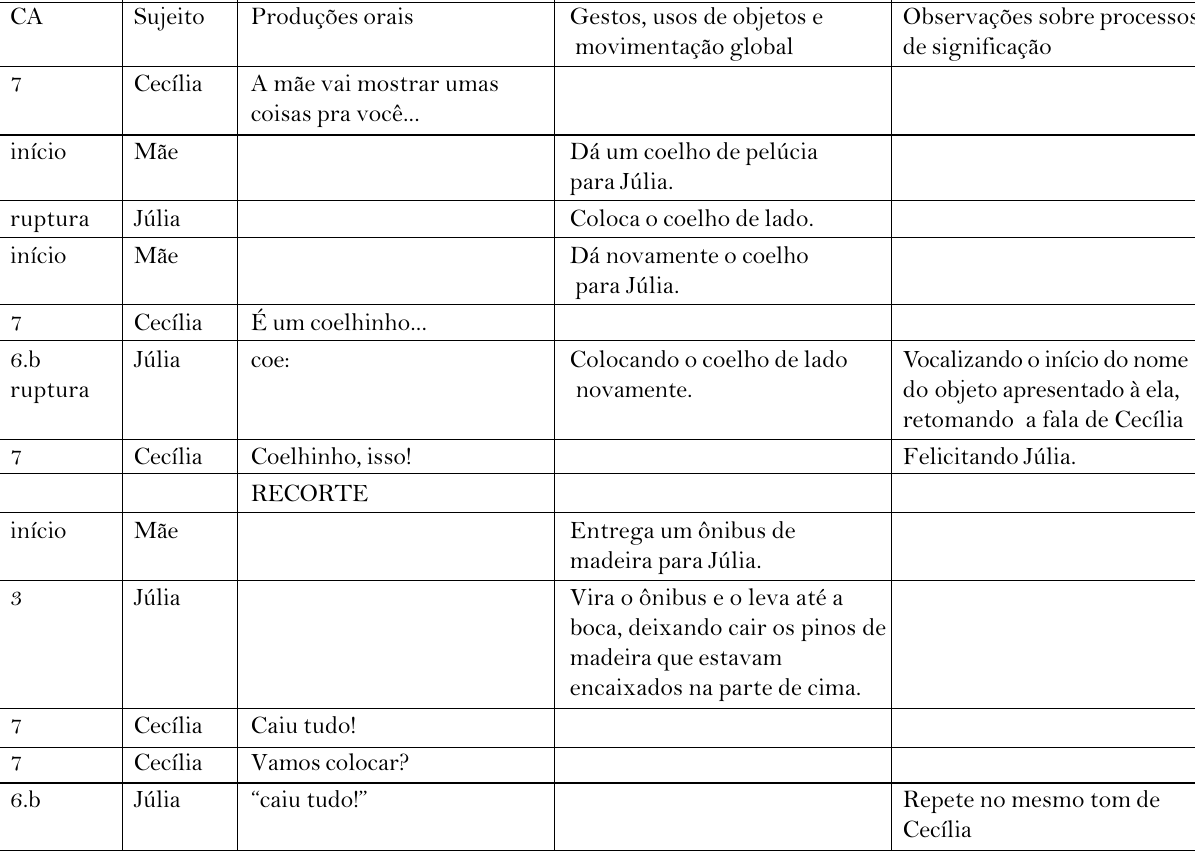
Nota . Cecília – pesquisadora